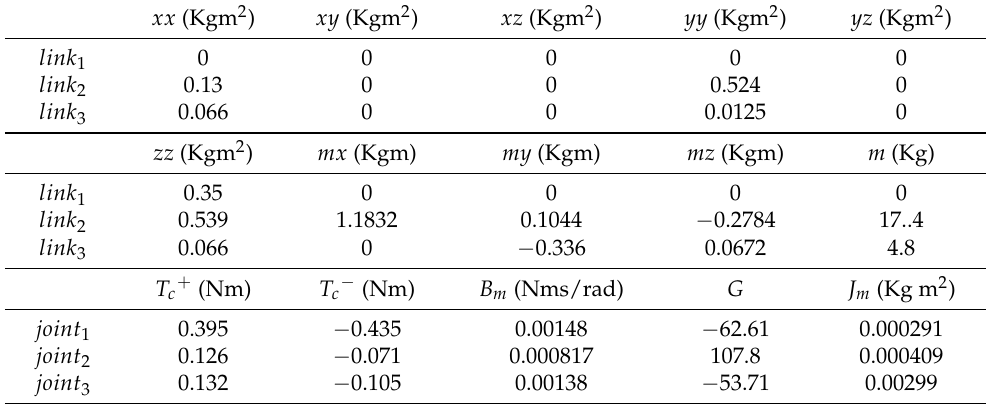
Table 5. Puma560 dynamic